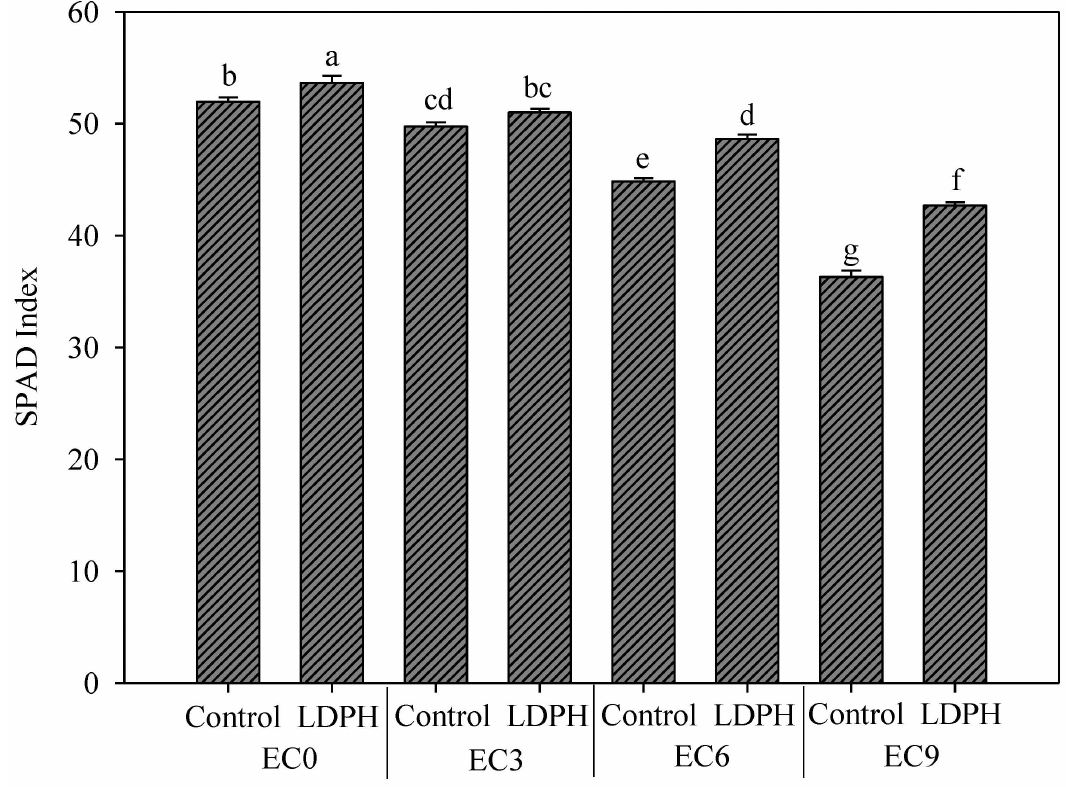
Figure 3. Soil–Plant Analysis Development (SPAD) index as affected by irrigation water salinity and biostimulant applications. Vertical bars indicate means ± standard error; different letters indicate statistical difference according to Tukey’s HSD test ( p ≤